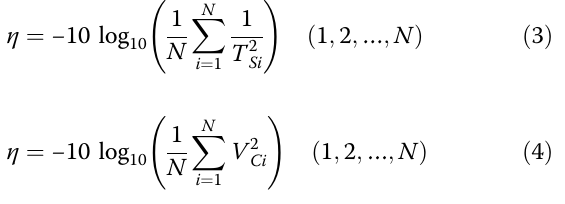
Grey relational coefficient for the data series